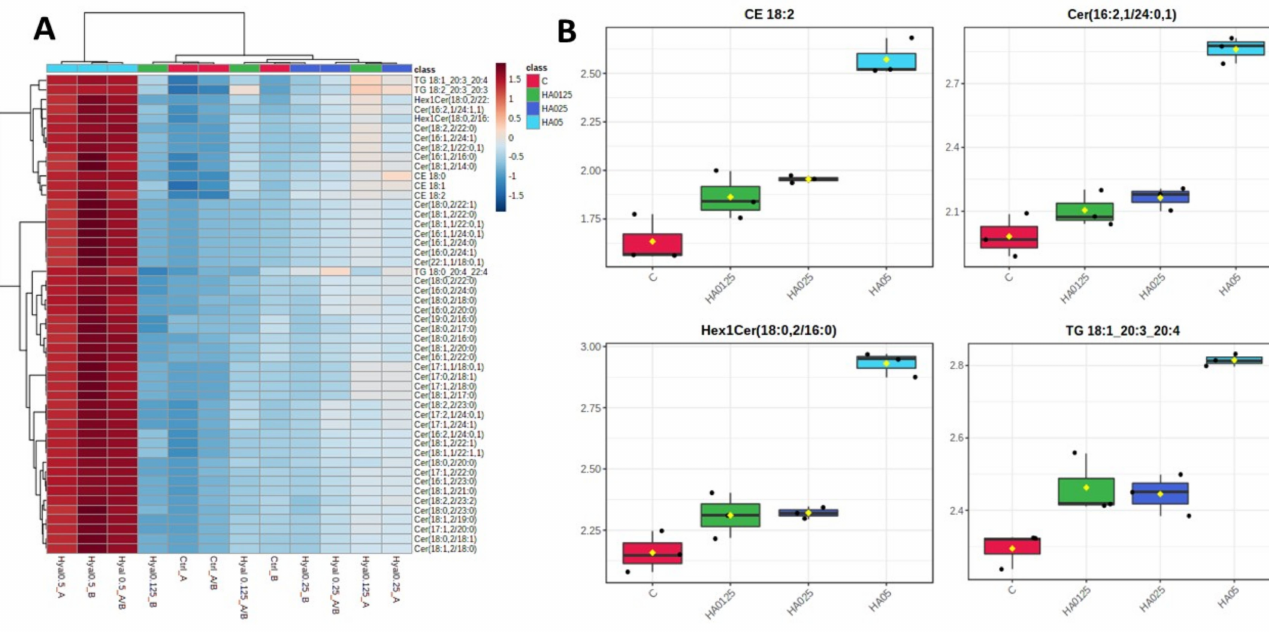
Figure 2. ( A ) Hierarchical clustering heatmaps of the 50 most significant altered lipids (one-way ANOVA and post-hoc analysis, p < 0.05) of all four groups. In red, the more expressed and related to the 0.50% LMW − HA group. Each colored cell on the map corresponds to a concentration value (in red those more expressed, in dark blue those with the lowest value) with samples in the rows and features in the columns; ( B ) box plot charts for representative altered lipids belonging to the main classes driving by one-way ANOVA (adjusted p -value (FDR) cut-off 0.05). Further than CEs, there was an increasing of several ceramides and Hex1Cer in- cluding Cer(16:1, 2/23:0) (log2 FC = 2.96, log10(p) = 2.37) (Figure 2B), Cer(18:1,